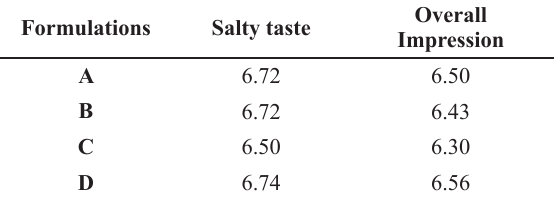
Sensory acceptance of the margarine formulations. Formulations